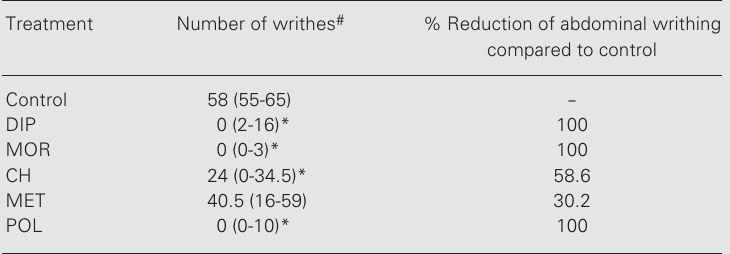
Table 2. Analgesic effects of methanol (MET) and cyclohexane (CH) extracts of aerial parts of Hypericum caprifoliatum (90 mg/kg, po ) and of the cyclohexane extract of aerial parts of H. polyanthemum (POL, 180 mg/kg, po ) on writhing induced by 0.8% acetic acid ( ip ) in